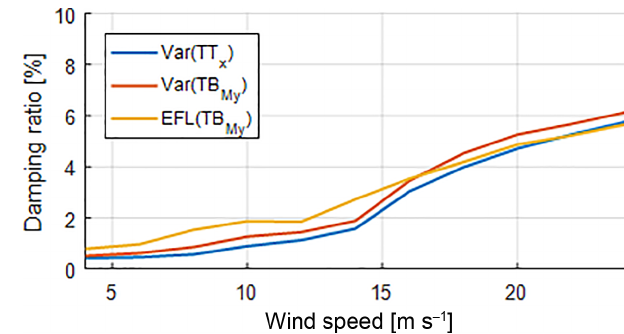
Figure 2. Damping ratios optimized for different output for DC I. The three different curves show the damping ratio for matching the variance of the tower top displacement in x direction (Var(TT x )), the variance of the tower bottom bending moment around the y axis (Var(TB My )), and the EFL of the tower bottom bending moment around the y axis (EFL(TB My